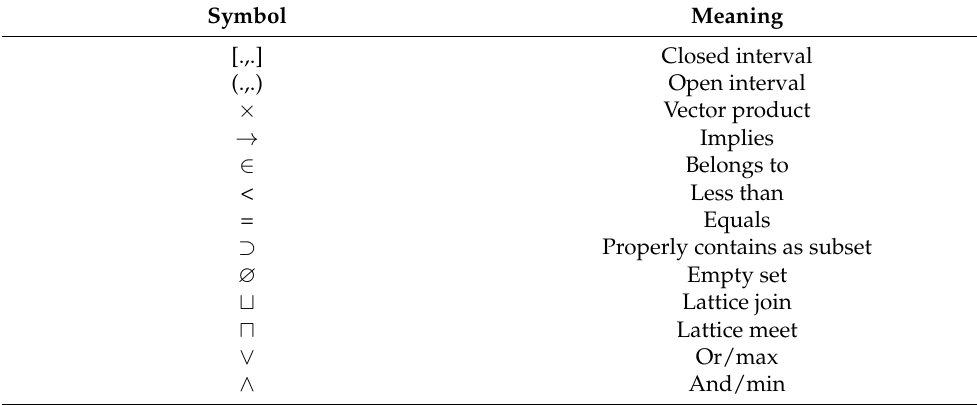
Table A3. List of